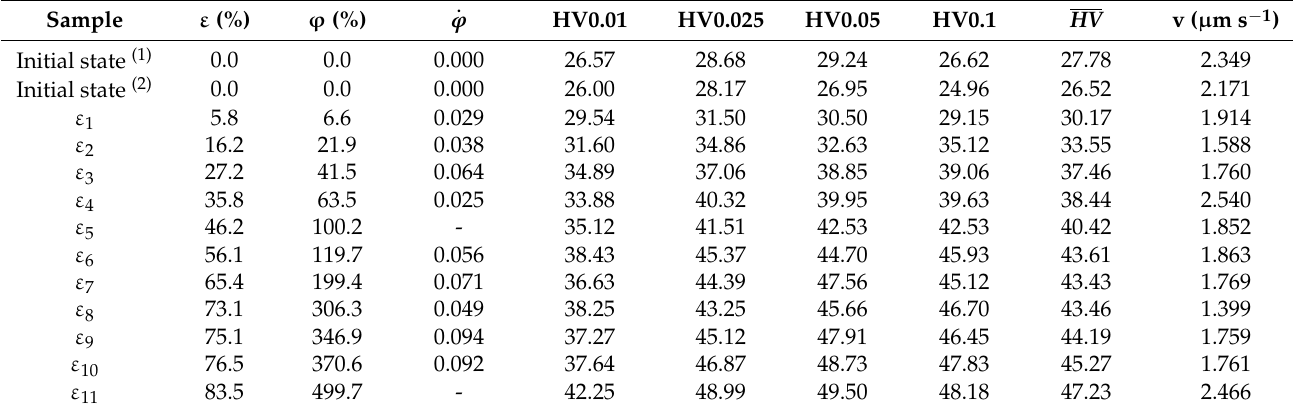
Table 2. Parameters of compression: the degree (amount) of the deformation ε (%), degree of the proportional lateral (transverse) extension ϕ (%), strain rate and average micro-hardness HV , and speed of the indenter for load 0.49035